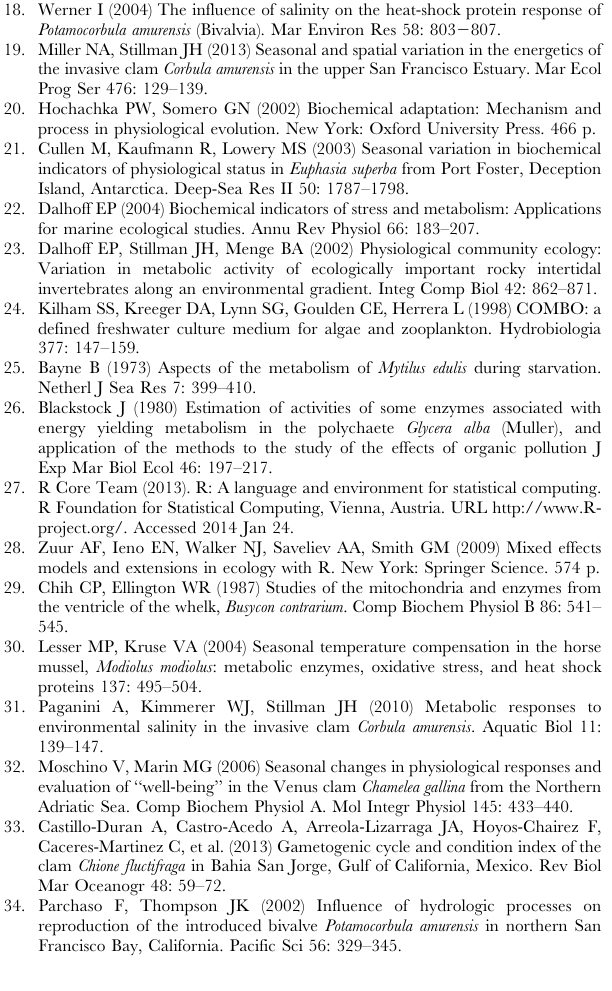
Figure S1 Percent clam survival in each experimental treatment at the conclusion of the 30-day laboratory acclimation experiment. Each experimental treatment began with 40